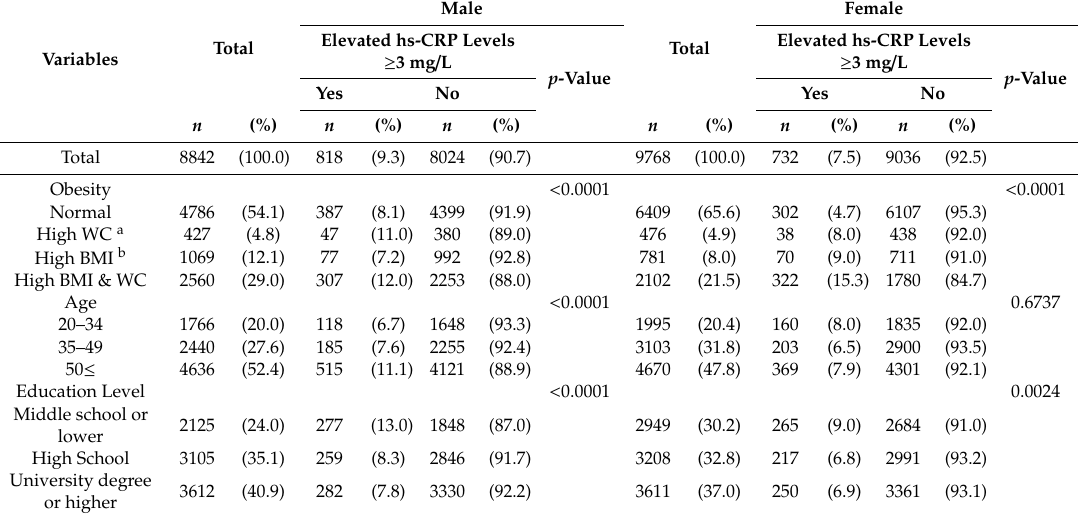
Table 1. General characteristics of study population (total = 18,610